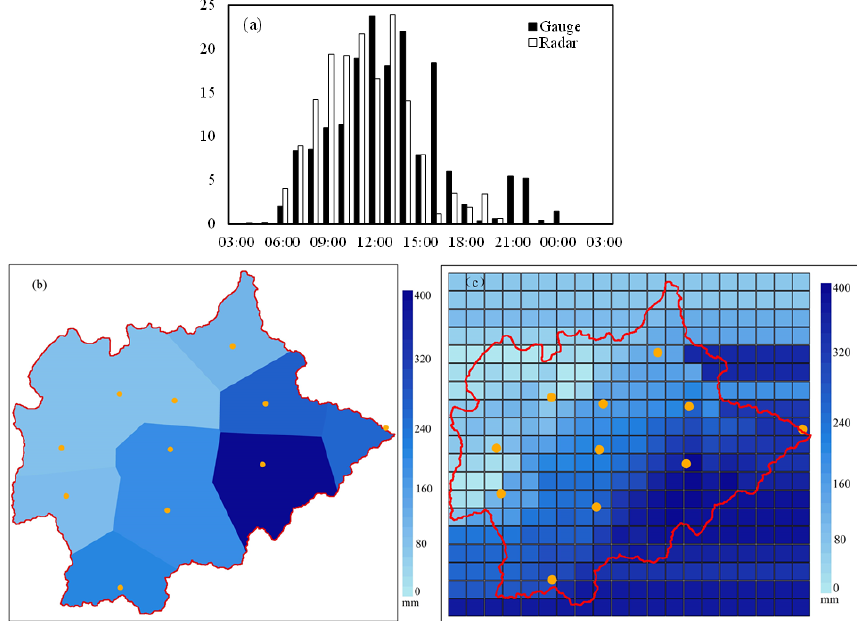
Figure 3. Rainfall observations from the rain gauges and the weather radar: (a) hyetograph of the hourly catchment areal rainfall; (b) spatial distribution of the 24h rainfall accumulation from the rain gauges; (c) spatial distribution of the 24h rainfall accumulation from the